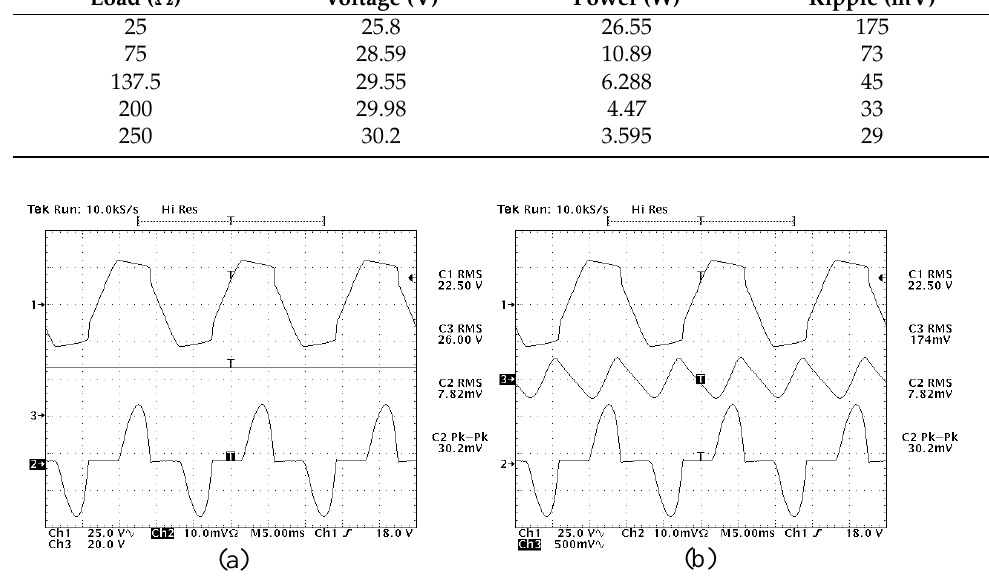
Figure 10. Experimental results of full-wave rectification: ( a ) DC components ( b ) the voltage ripples across the output voltage.